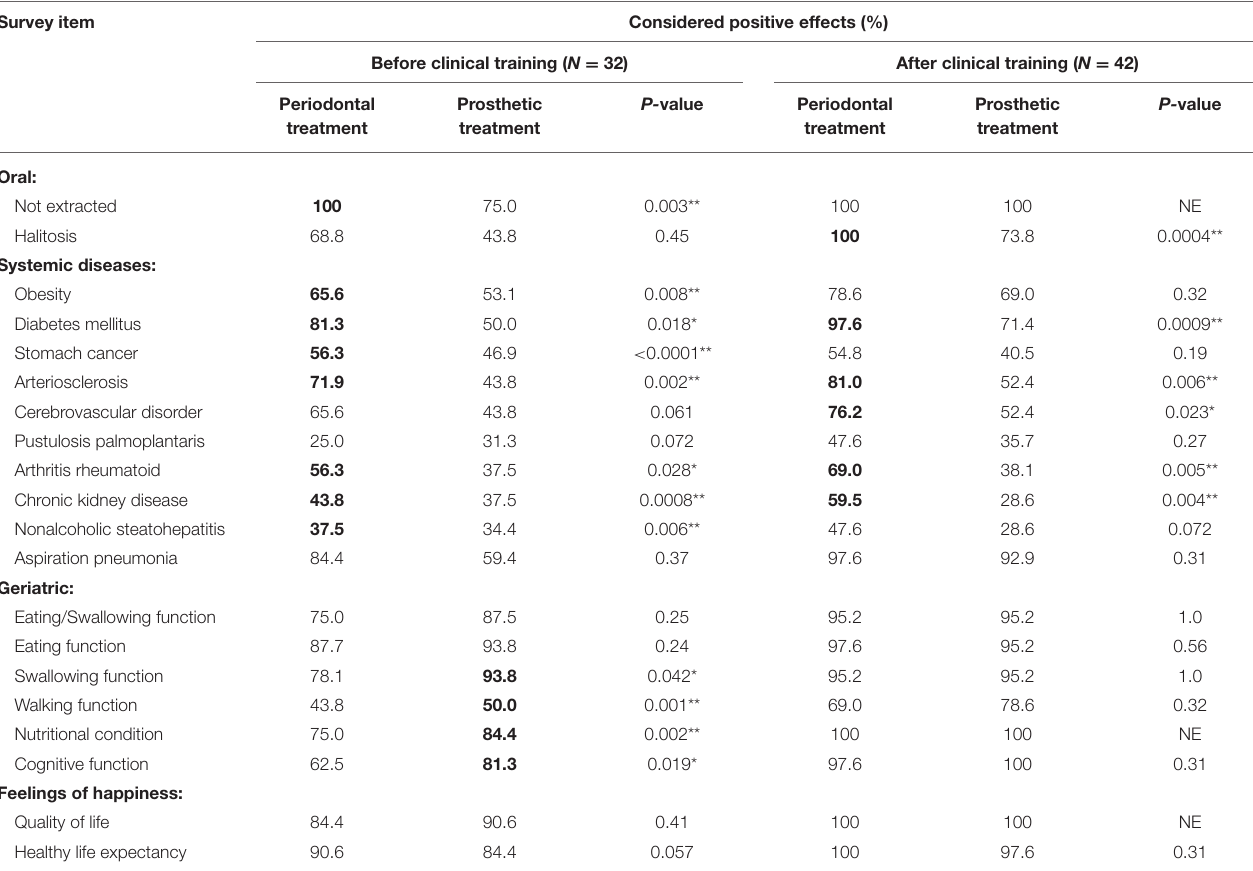
TABLE 3 | Comparison of awareness of the best course of treatment between periodontal and prosthetic treatment and the student’s recognition about the effect on diseases, symptoms, and conditions. Survey